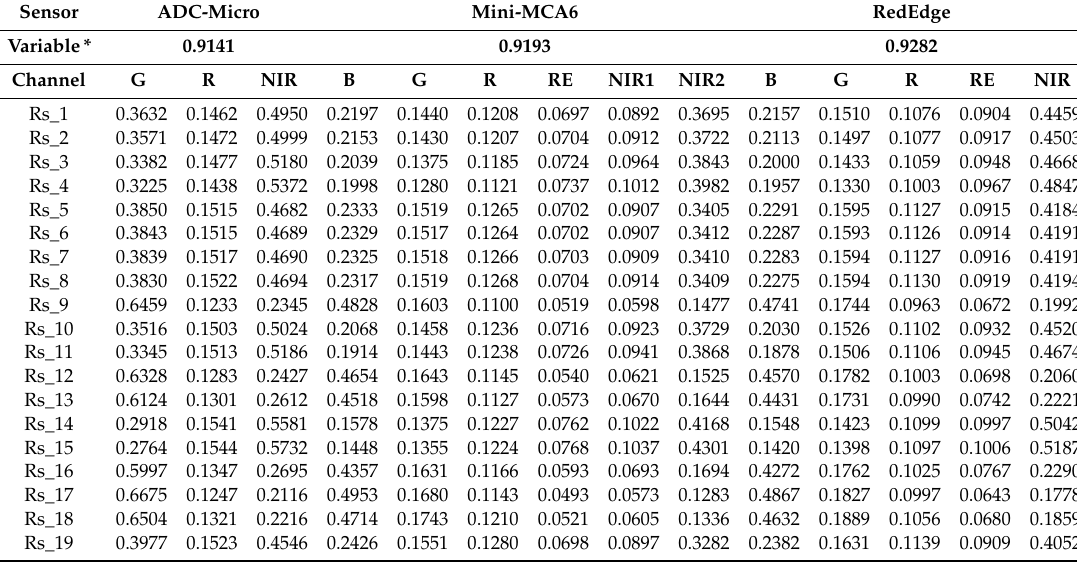
Table 4. Physical weighting coe ffi cients for sensors and solar irradiance